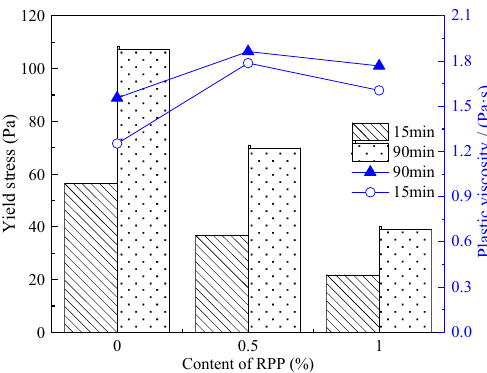
Figure 8. Yield stress and plastic viscosity of C-RPP pastes.